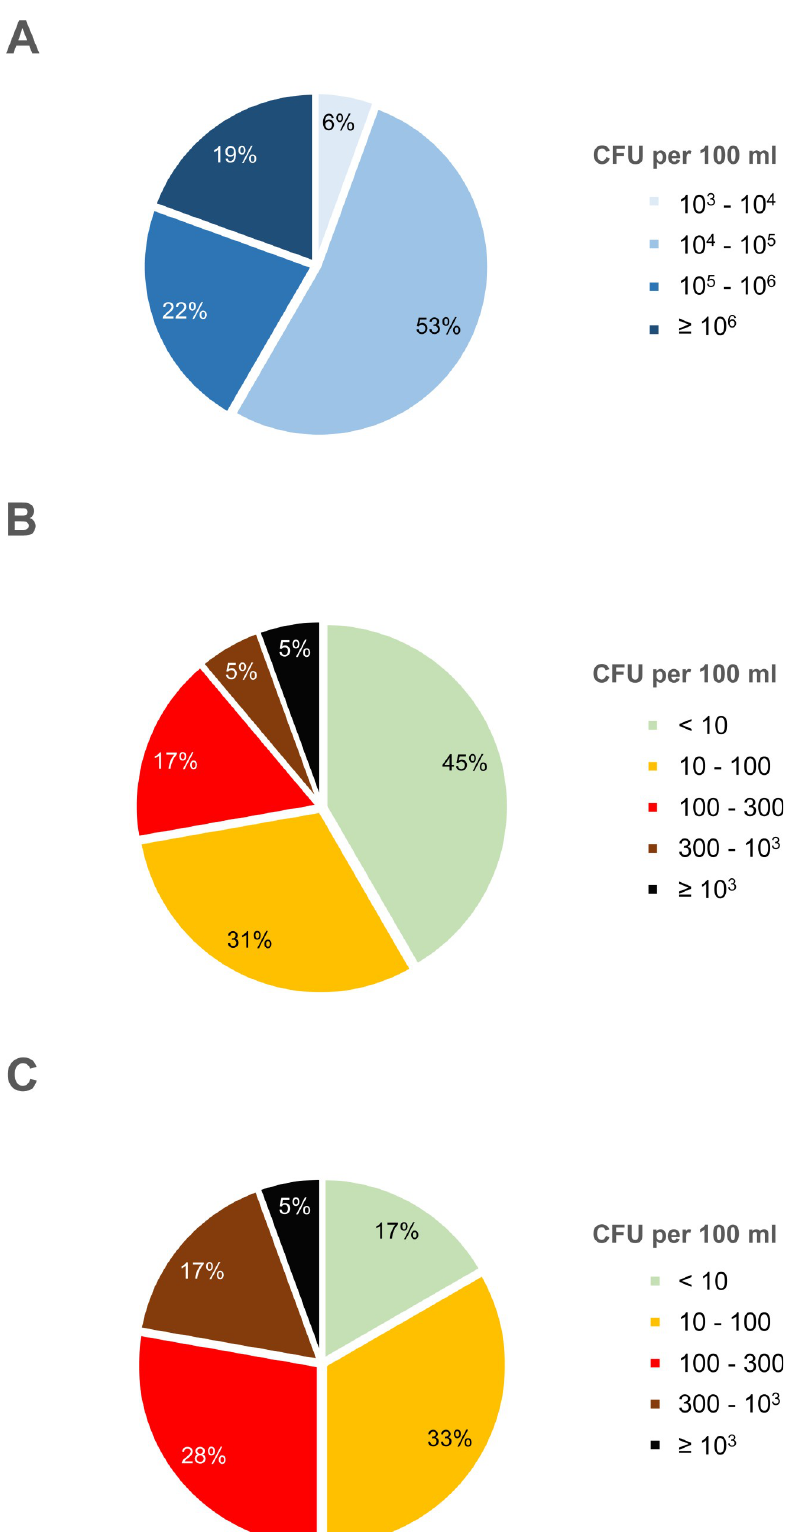
Fig 1. Aerobic mesophilic counts and generic E . coli and Enterococcus spp. counts in irrigation water. Colony forming units (CFU) per 100 ml of water are indicated. (A) Aerobic mesophilic counts. (B) E . coli . (C)